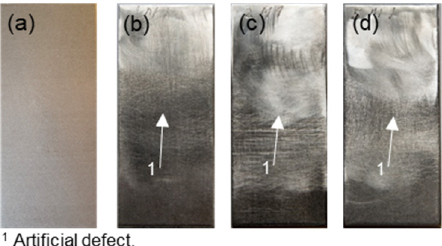
Figure 9. Specimen: ( a ) X1—reference sample; ( b ) 1M—failure size: 1 mm; ( c ) 2M—failure size: 2 mm; ( d ) 5M—failure size: 5 mm.